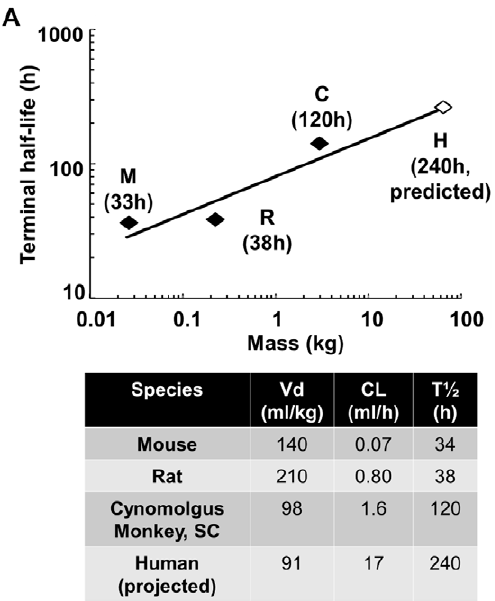
Figure 8. Allometric scaling human projection based on mouse, rat and monkey pharmacokinetic data. Allometric scaling was performed by fitting a linear regression model with the log of animal mass as the X variable and log of terminal half-life as the Y variable. The resulting linear model was extrapolated to a 70 kg human to produce a predicted value. The terminal half-life in humans can also be estimated using the predicted values for clearance (Cl) and volume of distribution (Vd) in the formula T K =0.693 6 Vd/Cl. Applying this formula yields a predicted terminal half-life of 240 hours in humans, which agrees with the linear